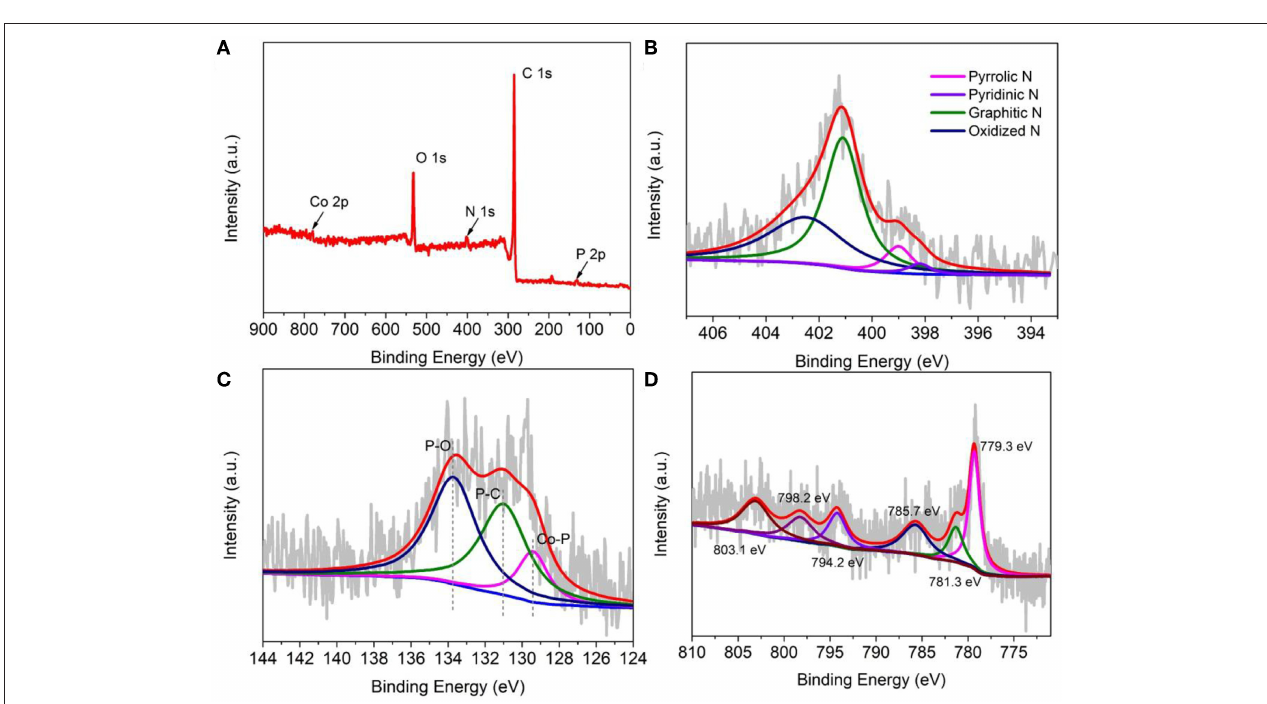
FIGURE 4 | X-ray photoelectron spectroscopy (XPS) of CoP-CGP2: (A) survey; (B) N 1s; (C) P 2p; and (D) Co 2p